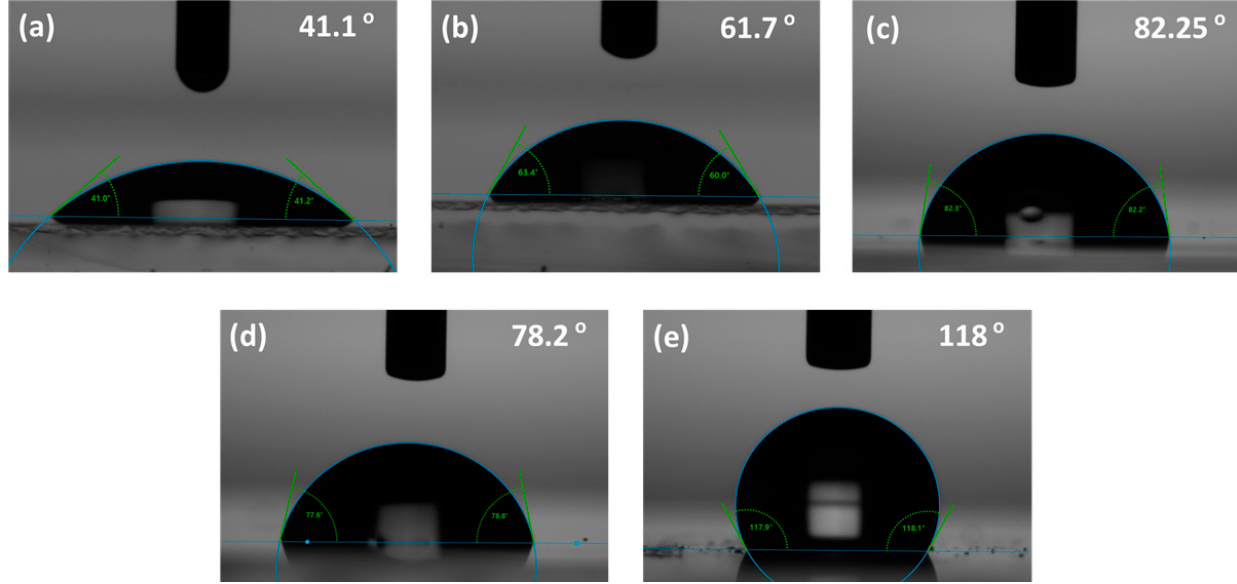
Figure 3. Contact angle measurement of the indium tin oxide (ITO) substrates with different treatments ( a ) bare ITO, ( b ) BA, ( c ) NA, ( d ) F-3SAM, and ( e )